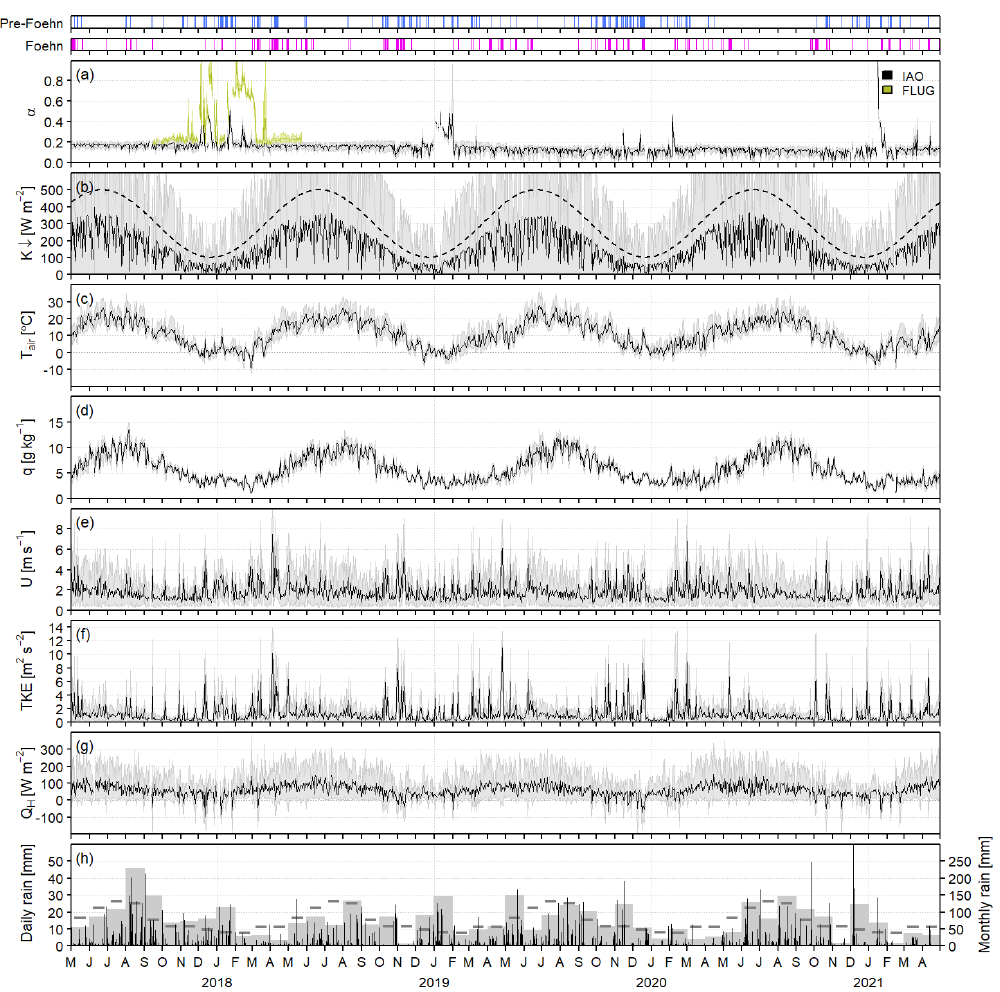
Figure 3. Time series of daily mean values (shading indicates 10–90th percentiles) of (a) albedo, (b) incoming shortwave radiation, (c) air temperature, (d) specific humidity, q , (e) wind speed, (f) turbulent kinetic energy and (g) sensible heat flux and (h) daily and monthly rainfall for IAO. In panel (h) , the thick horizontal bars indicate the 1981–2010 normal monthly rainfall (ZAMG, 2021). The albedo for the FLUG site is also shown in panel (a) . In panel (b) , the dashed line indicates the top-of-atmosphere irradiance. The top panels show the occurrence of foehn and pre-foehn conditions (see Appendix A for